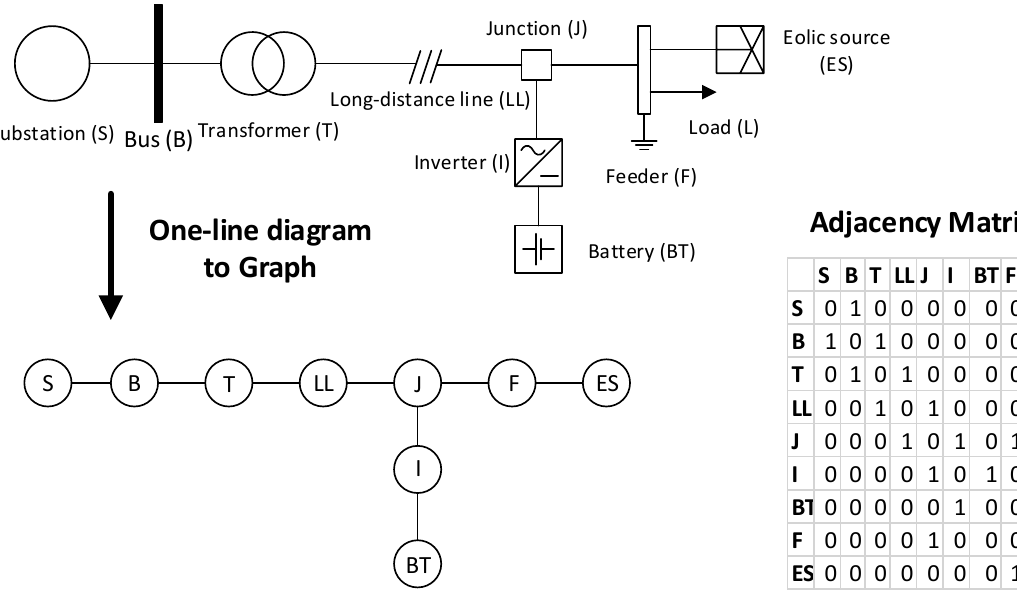
Figure 5. Topology configuration from one-line diagram to graph and its respective adjacency